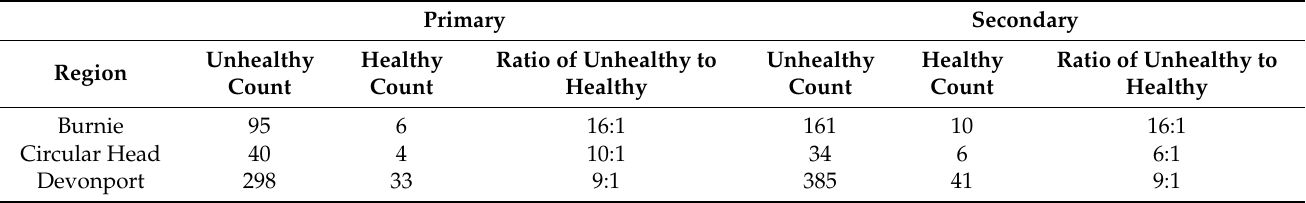
Table 3. Abundance of Tier 2 (unhealthy) and Tier 1 (healthy) food outlets within walking distance of primary and secondary